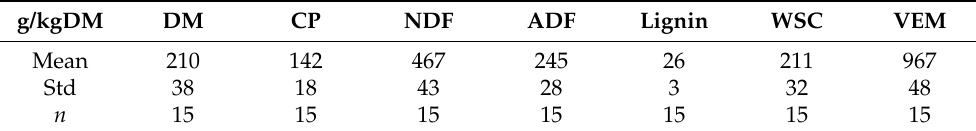
Table 2. Nutritional grass values.